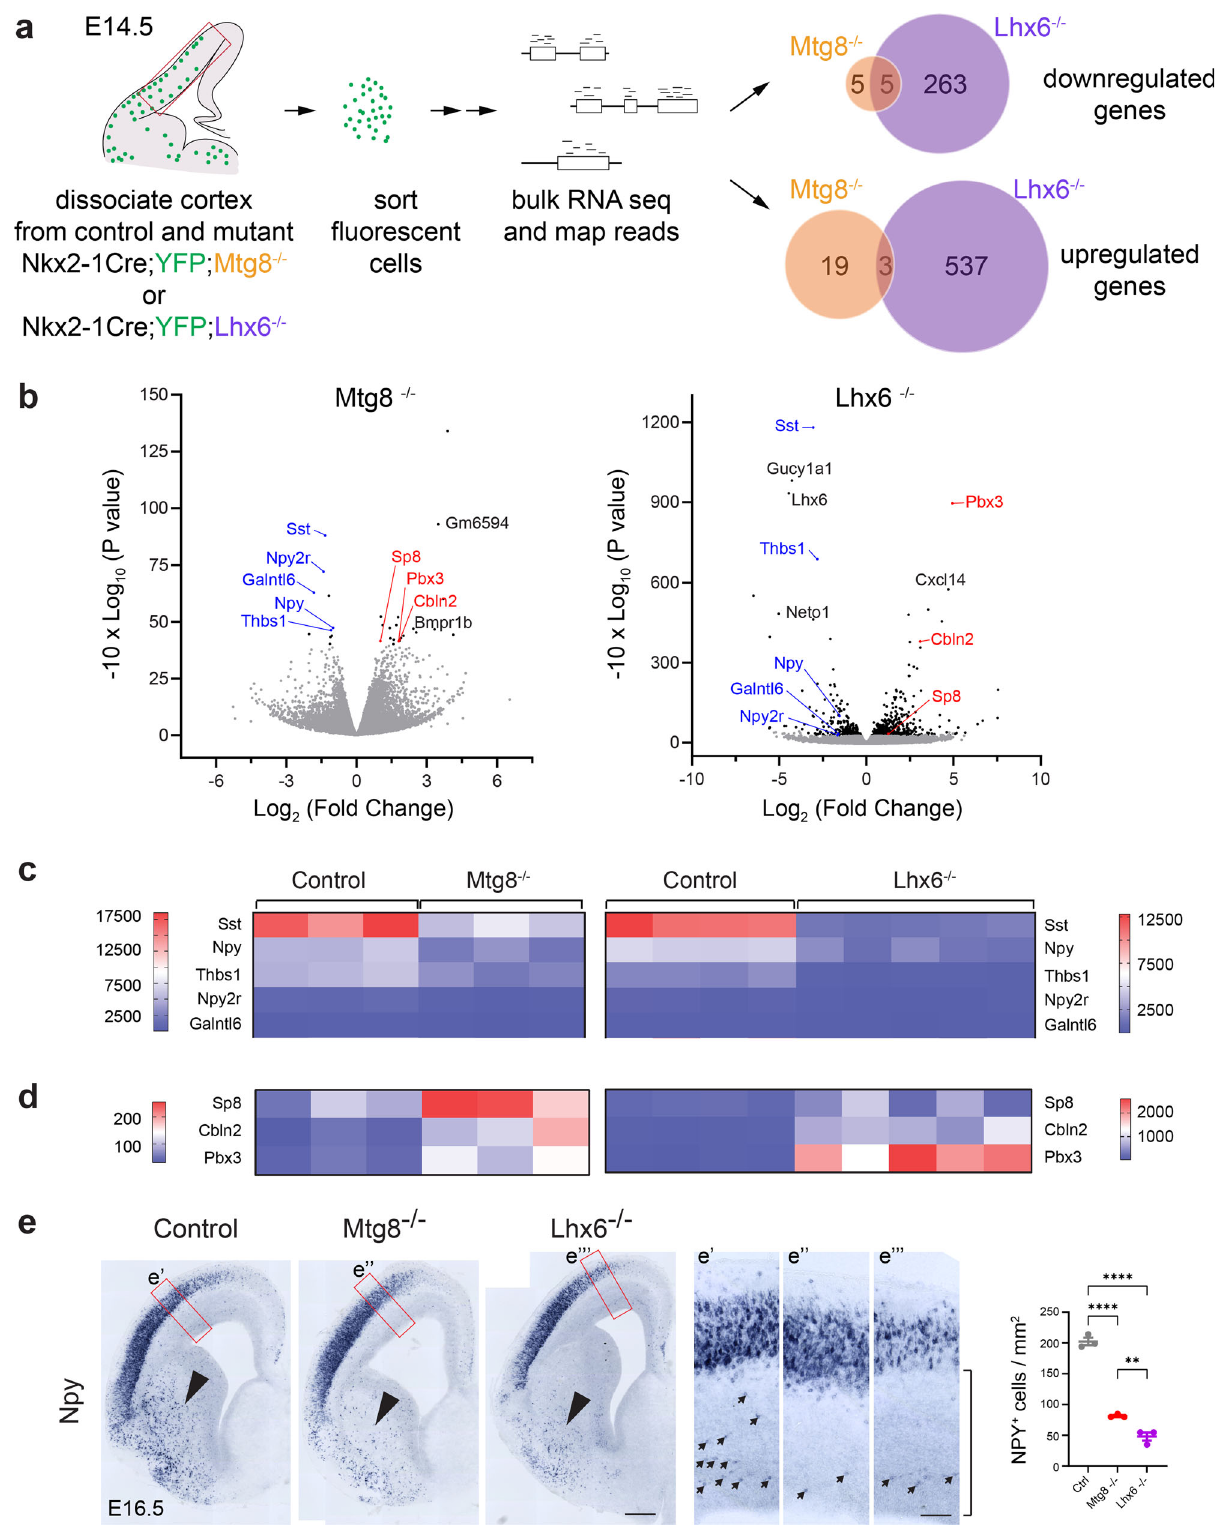
+ve Venus -ve transplanted MGE cells were used as controls. Over- expression of MTG8 in MGE lineage cells resulted in a small but signi fi cant increase in the percentage of SST +ve cells (~14% increase). NPY +ve cells more than doubled in numbers among the transduced population (~140% increase). These changes were accompanied by a small but signi fi cant decrease in PV +ve cells (~35% decrease) (Fig. 6b).